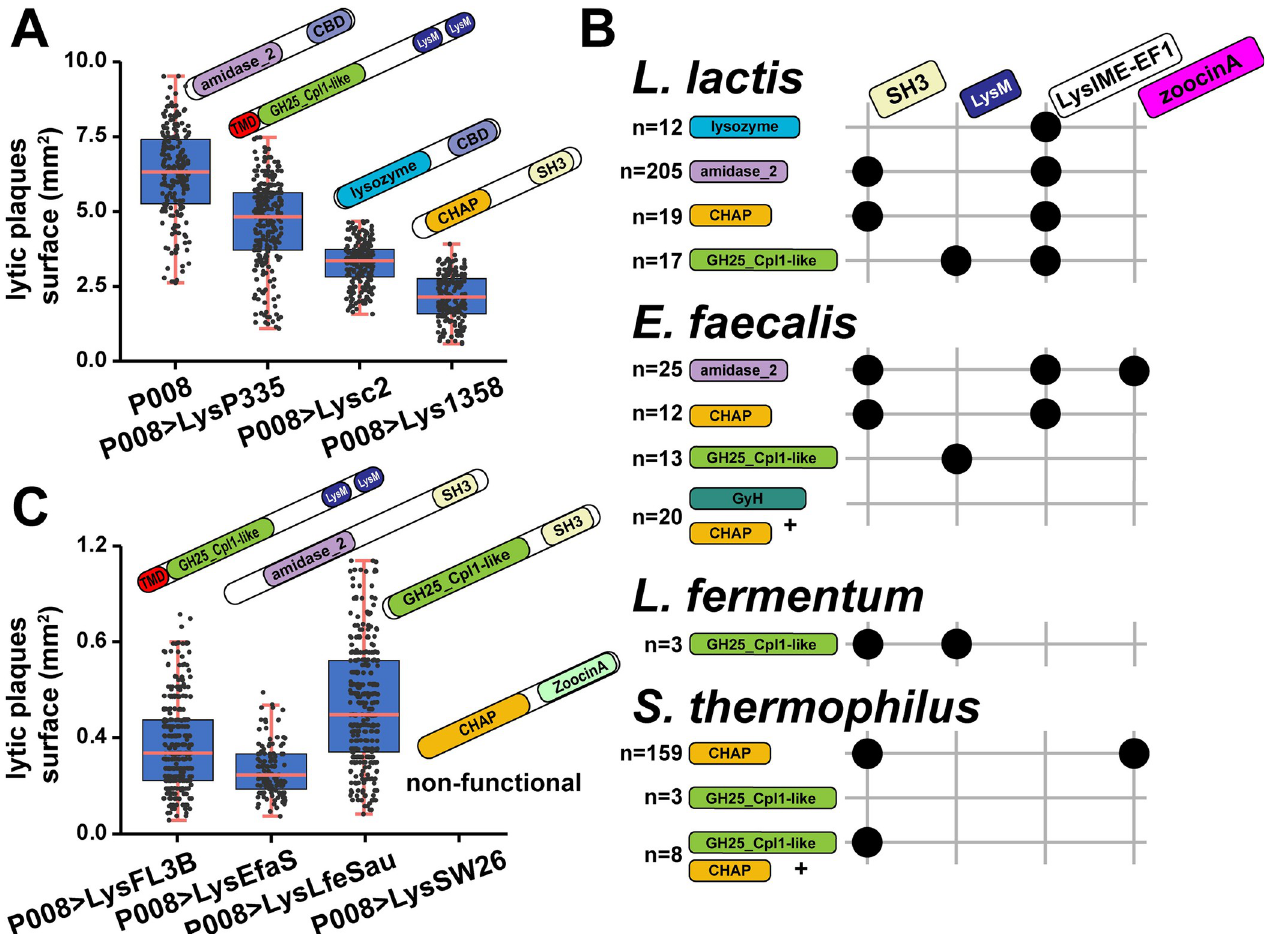
Fig 6. The gene coding for the endolysin in the virulent phage P008 was swapped by genome editing with homologs from other lactococcal phages or phages infecting other gram-positive bacteria. (A) Size of the lytic plaques produced by phage P008 and the mutants with an endolysin from phage P335 ( > LysP335), c2 ( > Lysc2), or 1358 ( > Lys1358) (S1 Data). L . lactis IL1403 was used as host for plaque visualization using a double layer agar assay. ( B) Endolysin diversity in phages infecting other gram-positive bacteria. Phages that infect Enterococcus faecalis , Limosilactobacillus fermentum, or Streptococcus thermophilus were selected as they share homology with lactococcal phages (S8 Fig and S7 Data). The association of a certain type of CD with CBD is indicated by a black dot. Graphical representation was inferred from the phylogenetic analysis of endolysin diversity in these phages (S9, S10, and S11 Figs and S7 Data). ( C) Size of the lytic plaques of phage P008 and the mutants that contain the endolysins from the E . faecalis phages phiFL3B (ACZ64148.1, P008 > LysFL3B) and vB_EfaS_Ef5.4 (QBZ69829.1, P008 > LysEfaS), L . fermentum phage LfeSau (AIY32273.1, P008 > LysLfeSau), and S . thermophilus phage SW26 (AYP29873.1, P008 > LysSW26) (S1 Data). L . lactis IL1403 was used as the host strain. Measures were done in triplicates. CBD, cell wall–binding domain; CD, catalytic domain; TMD, transmembrane